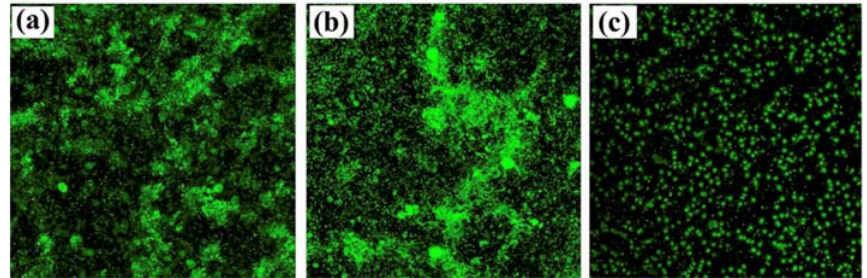
Figure 6. Confocal laser scanning microscopy (CLSM) images of bare polypropylene (PP) ( a ), graphene oxide coated PP ( b ) and graphene oxide/silver nanoparticles coated PP ( c ). Reprinted with adaptations from [67], under the terms of Creative Commons CC BY license.